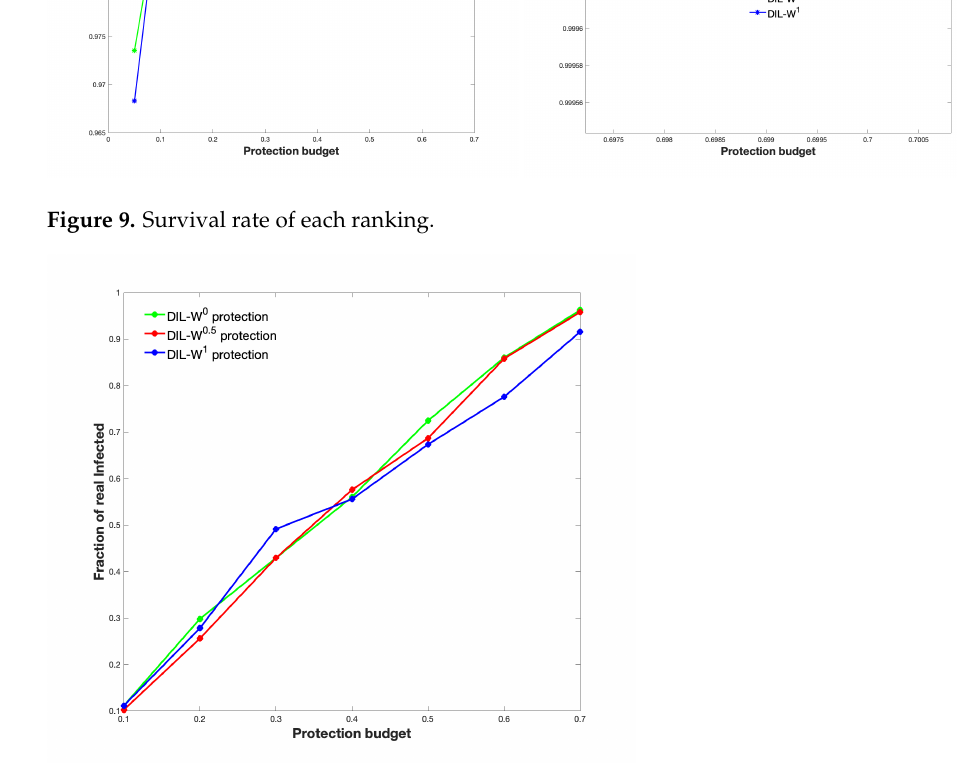
Figure 10. Relationship between the real infected and those immunized according to the different DIL-W α ranking.